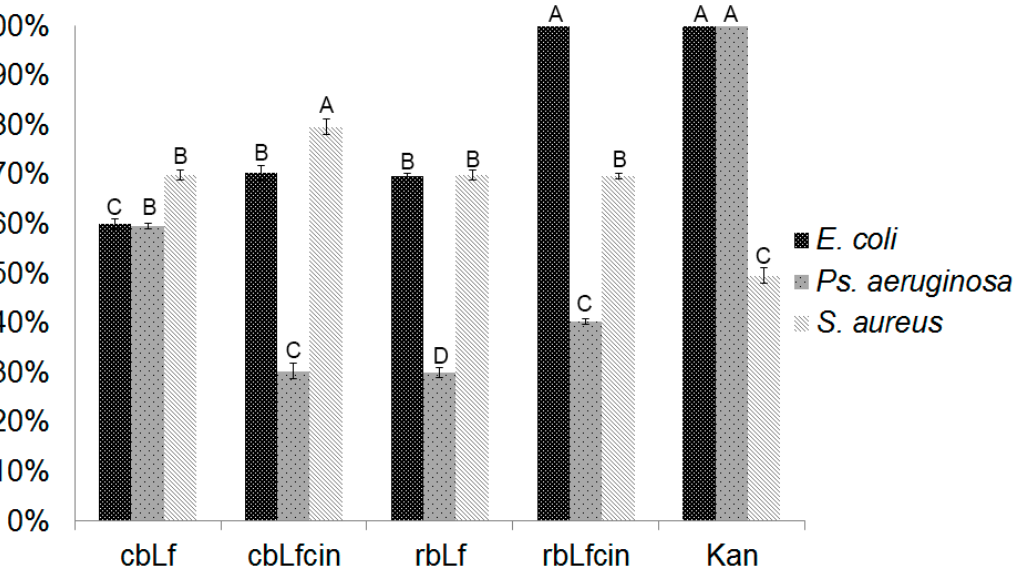
Figure 6. Antibacterial activity of rbLf. Bacterium were incubated in Luria-Bertani (LB) broth and treated with 5.0 ng/mL. Inhibition growth percentage was calculated relative to commercial bLf and commercial antibiotics. cbLf = commercial bovine lactoferrin; cbLfcin = commercial bovine lactoferricin; rbLf = recombinant bovine lactoferrin. rbLfcin = recombinant bovine lactoferricin; Kan = kanamycin. Group A belongs to treatment with highest percentage of inhibition, while group D belongs to treatment with lowest inhibition. Groups B and C are intermediate, however they are statistically different.